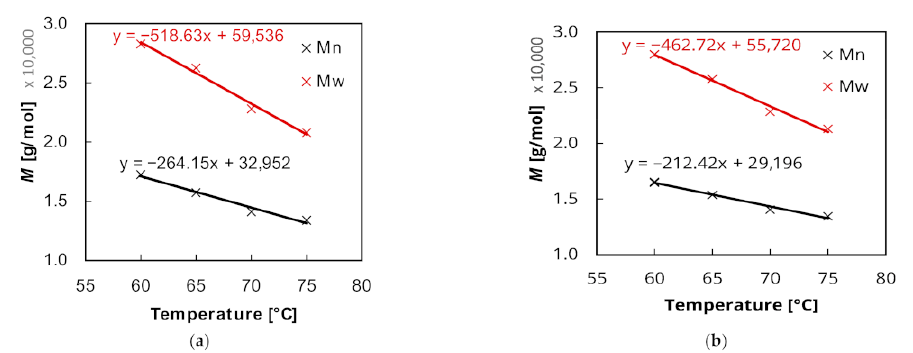
Figure A1. Effect of temperature on the number- and weight-average molecular weight during the polymerisation of acrylic